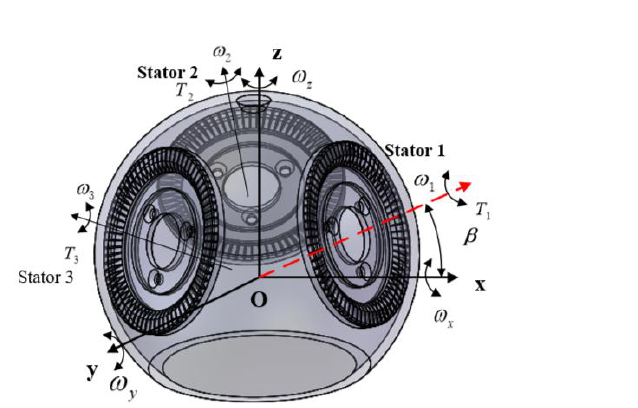
Figure 2. Angular velocity and torque distribution diagram of multi-degree-of-freedom spherical ultrasonic motor.